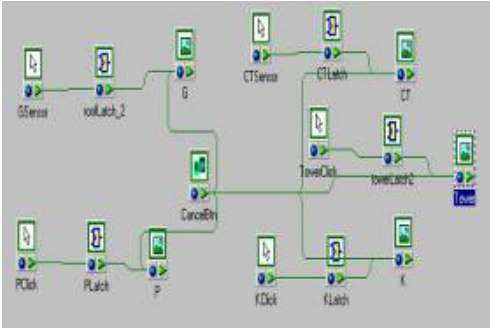
Figure 9. text of interaction for the Taipei Xia Hai City God Temple